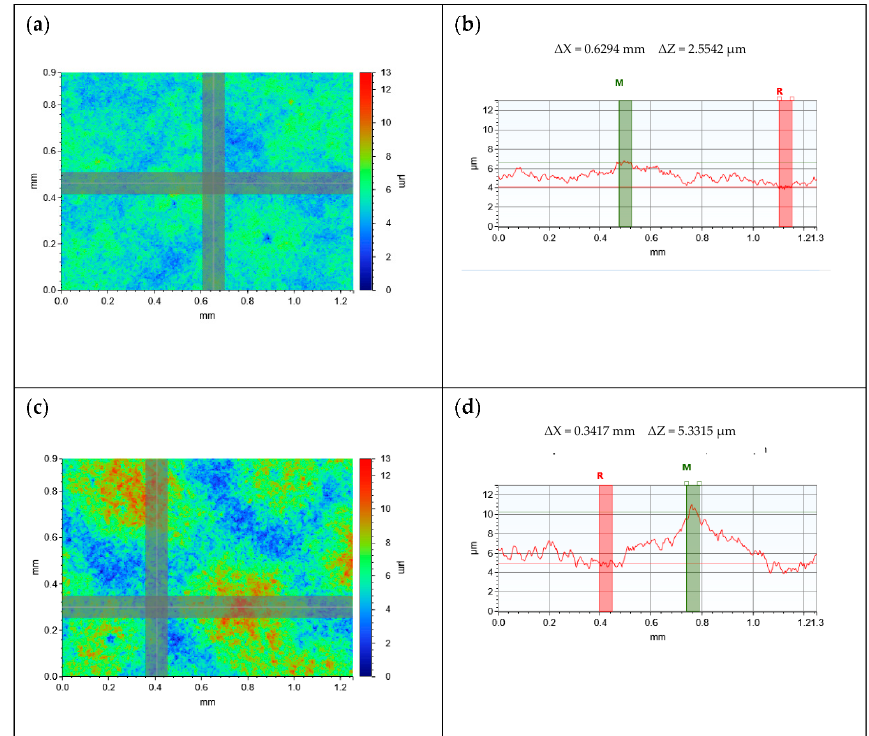
Figure 2. White light images at 5× magnification of the single layer print at the centre over a 1.2 × 0.9 mm scan area, where wrl represents the height of the surface in μ m of ( a ) the single layer carbon, ( c ) the single layer silver. Cross-sectional X-profile of the white light images showing the roughness across the surface of the prints in microns, where Δ Z represents the difference in height between the reference area (R) and the measure area (M) for ( b ) single layer carbon, ( d ) single layer silver.